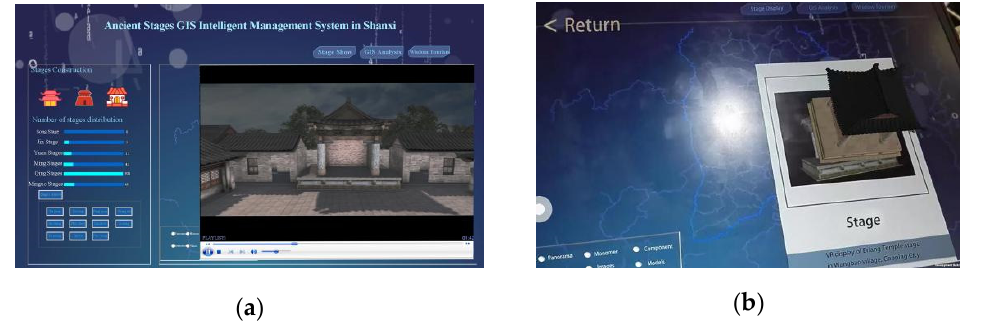
Figure 13. Digital display. ( a ) Digital short film. ( b ) AR interaction.